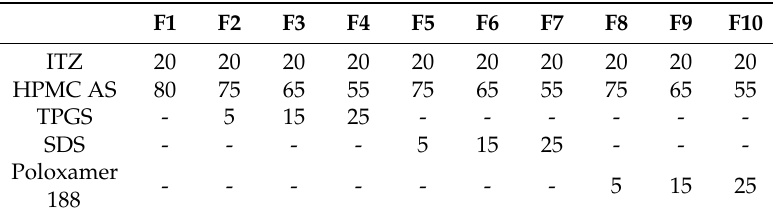
Table 1. Formulation compositions of ITZ-loaded ASDs (wt